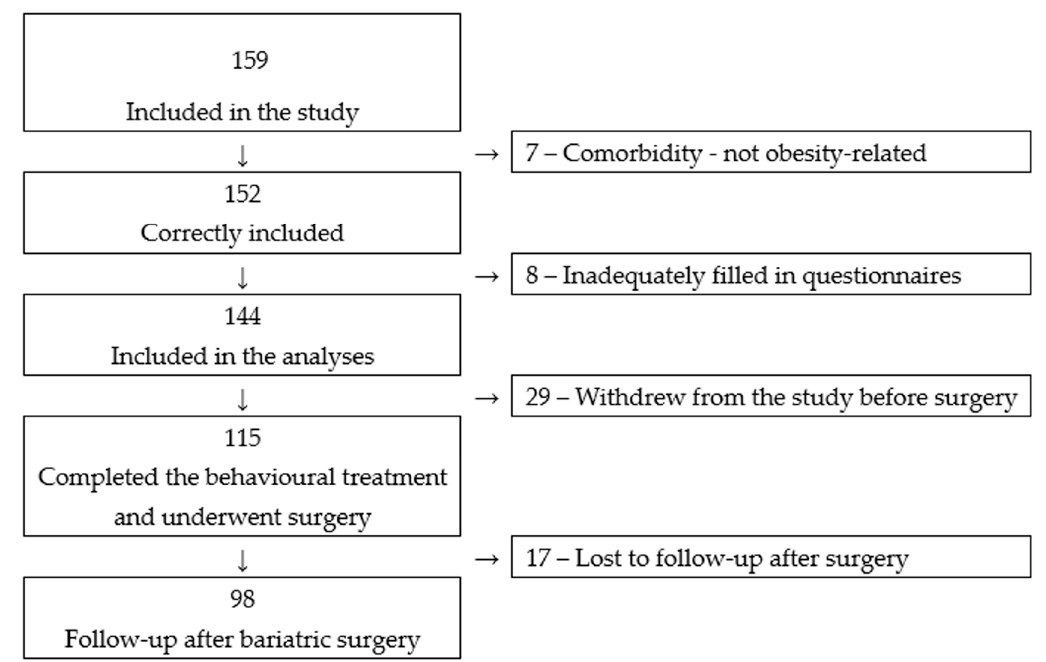
Figure 1. Participants in the study.